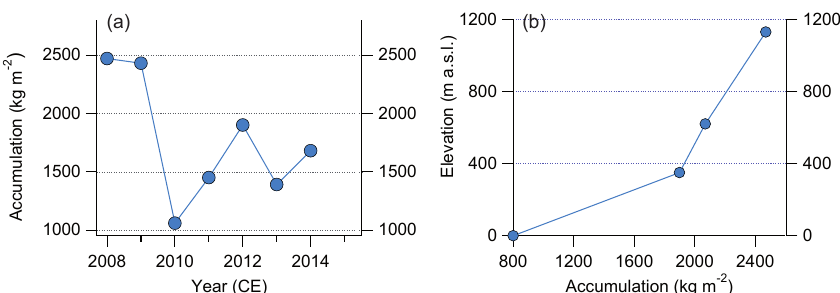
Figure 13. (a) Accumulation rates for Plateau Laclavère during 2008–2014 estimated from the stable water isotope composition of firn cores OH-6, OH-9 and OH-10 and their respective density profiles. (b) Accumulation variability for the west flank of the northern Antarctic Peninsula from the coast to Laclavère Plateau. Accumulation rates were derived from precipitation at O’Higgins Station at sea level and firn cores (OH-4, OH-5 and OH-6) for higher altitudes.